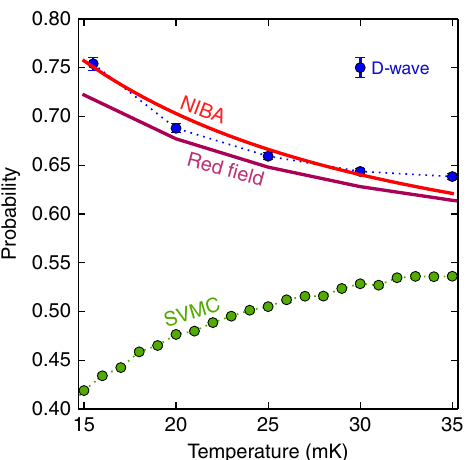
Figure 6 | Probability of success versus temperature for h L ¼ 0.44. The decreasing probability with increasing temperature is only matched with theories based on quantum tunnelling. This is the opposite tendency to thermal activation (SVMC). The annealing time is 20 m s. Both Redfield and NIBA use only measured parameters (no fitting). SVMC uses an algorithmic temperature equal to the physical temperature and 128,000 sweeps. In this temperature range the lowest two states (the double-well potential) account for all the probability (0.9998 for D-Wave, 0.99998 for SVMC). Error bars (s.e.m.) are smaller than